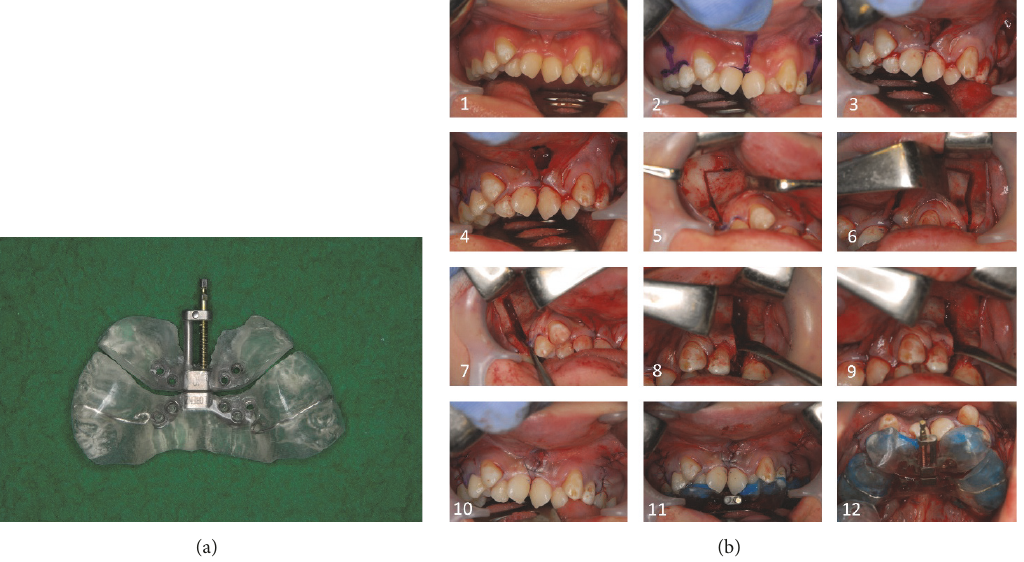
Figure 6: Maxillary anterior segmental distraction osteogenesis (MASDO). (a) Distractor. (b) The numbers indicate the order of the